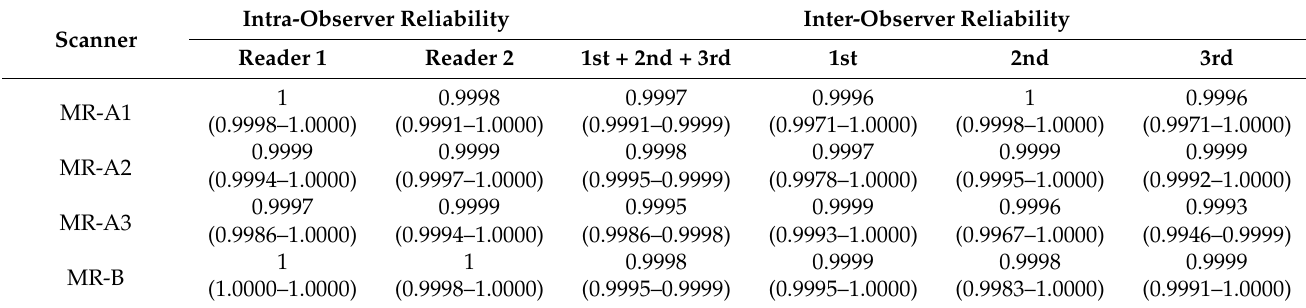
Table 3. Results of intra-observer and inter-observer reproducibility analyses for the phantom study.